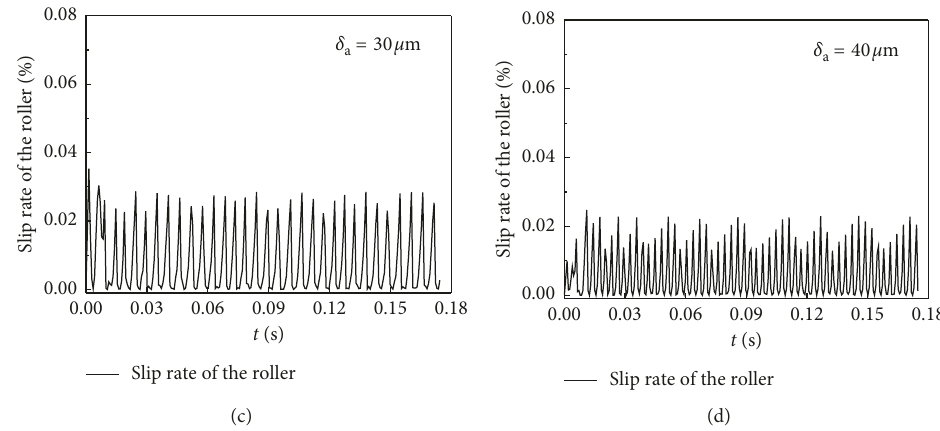
Figure 12: The slip rate of the conical roller. F